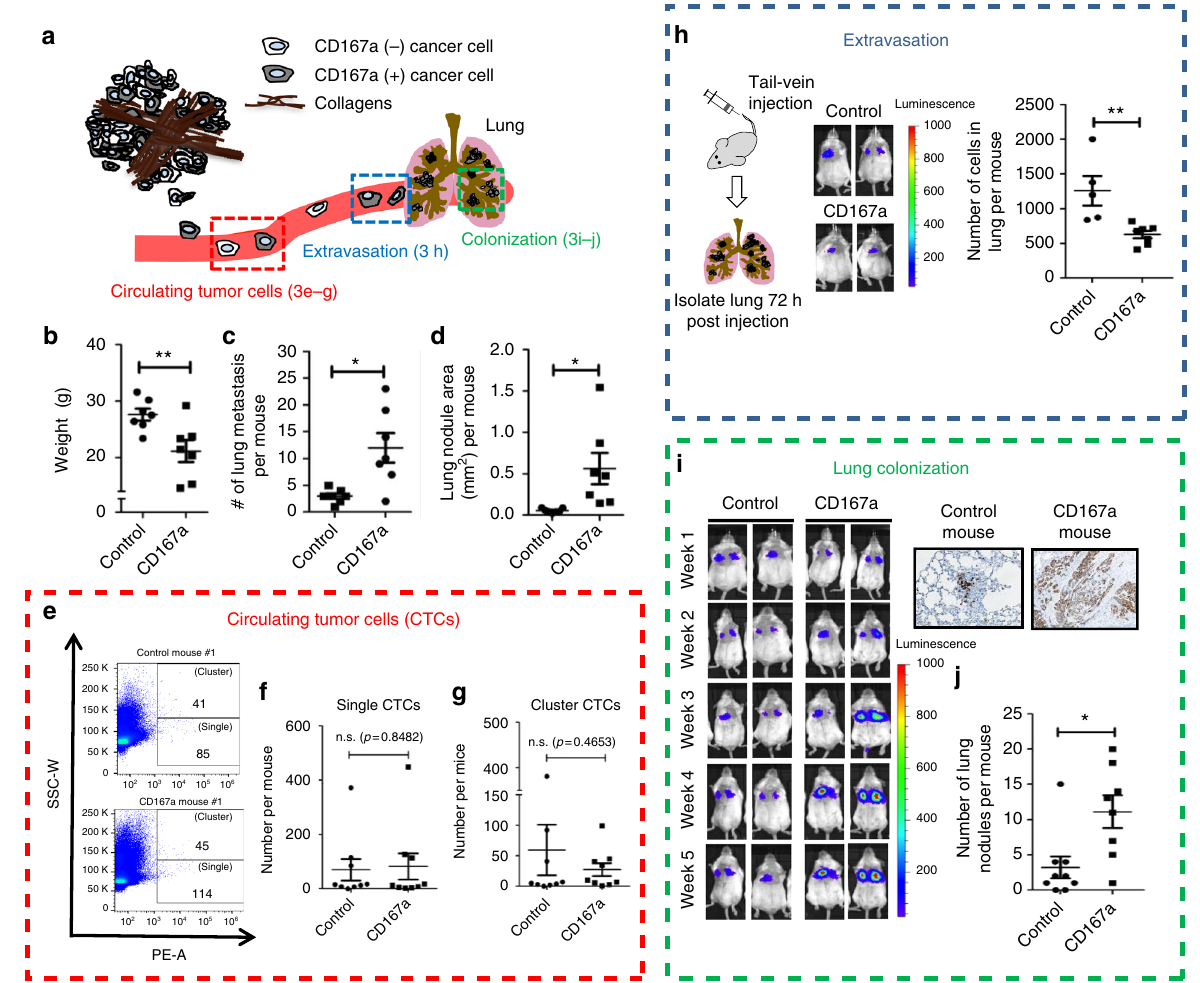
Fig. 3 CD167a facilitates lung colonization in vivo. a Schematic representation of the metastatic cascade: this includes intravasation of tumor cells into the circulation as circulating tumor cells (CTCs) (red box), extravasation of CTCs from the circulation (blue box), and colonization at distant organ, e.g. lung (green box). b Endpoint analysis of mouse weight ectopically injected with control or CD167a-overexpressing T24 cancer cells ( n = 7) over a 12-week period. c Quanti fi cation of metastatic nodules in lung of mice injected with control or CD167a-overexpressing T24 cancer cells ( n = 7). d Quanti fi cation of metastatic nodule total area (mm 2 ) in lungs of mice injected with control or CD167a-overexpressing T24 cancer cells ( n = 7). e – g The examination of CTCs frequency in a spontaneous metastatic model. Peripheral blood was collected from mCherry-CBLuc-control or CD167a-overexpressing mCherry- CBLuc-T24 cells tumor-bearing mice and analyzed by fl ow cytometry to quantify fl uorescent CTCs. Frequency of single and cluster CTCs is shown in f , g , respectively. n = 9. h Left panel: Schematic illustration of the tail-vein injection model. Middle panel: Representative bioluminescence images (BLI) of mice injected with control or CD167a-overexpressing mCherry-CBLuc-T24 cancer cells. Right panel: Quanti fi cation of cancer cell extravasation in the lungs of mice injected with control ( n = 5) or CD167a-overexpressing mCherry-CBLuc-T24 cancer cells ( n = 7) 72 h post-injection after immunohistochemical analysis. i Left panel: Representative bioluminescence images of mice injected with mCherry-CBLuc-control or mCherry-CBLuc-CD167a-overexpressing- T24 cancer cells via tail-vein, temporally tracked for tumor colonization up to 5 weeks post injection (Control n = 9, CD167a, n = 8). j Histological lung sections from mice injected with control and CD167a cancer cells from i were independently analyzed for graphical quanti fi cation of metastatic nodules in the lung. Statistical analysis: a two-tailed, unpaired Student ’ s t -test. Error bar: mean ± SEM. * p < 0.05, ** p <